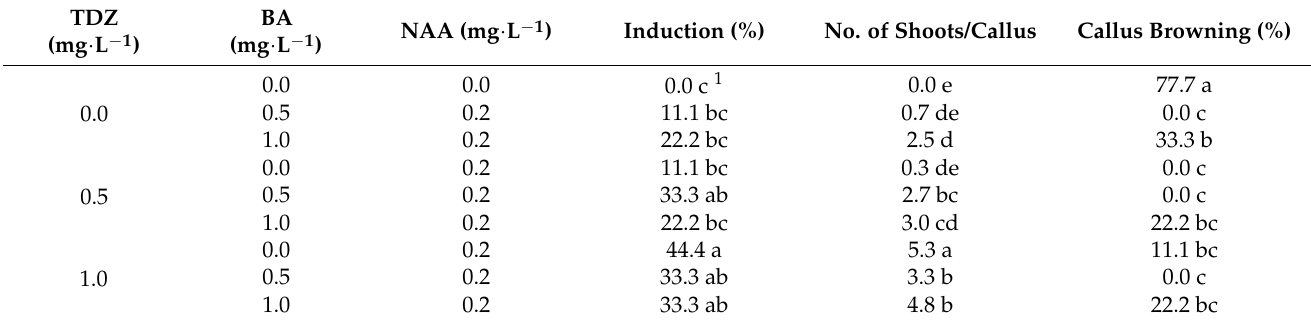
Table 2. Shoot regeneration from calli in Cotoneaster wilsonii .